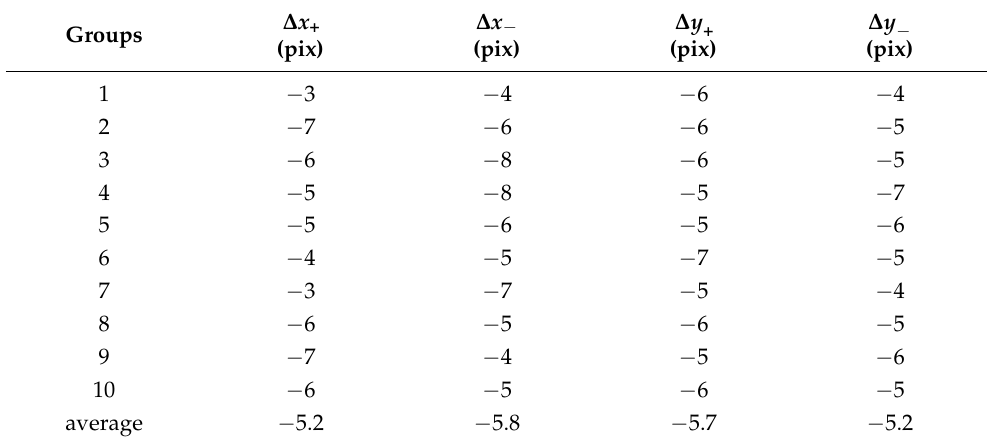
Table 3. Results of ∆ x + , ∆ x − , ∆ y + and ∆ y −